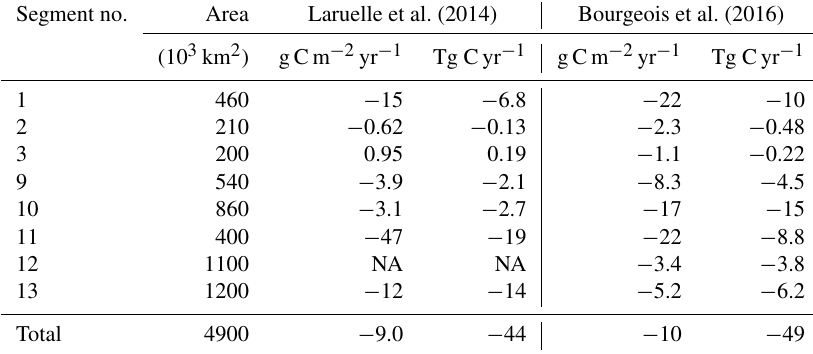
Table 1. Regional estimates of net air–sea CO 2 flux from a global data synthesis and a global biogeochemical model for the MARgins and CATchments Segmentation (MARCATS) regions. MARCATS segments are named as follows: (1) northeastern Pacific, (2) California Current, (3) eastern tropical Pacific, (9) Gulf of Mexico, (10) Florida upwelling, (11) Labrador Sea, (12) Hudson Bay, (13) Canadian Arctic Archipelago. Positive numbers indicate a flux to the atmosphere; 1Tg = 10 12 g. Segment no. Area Laruelle et al. (2014) (10 3 km 2 ) gCm − 2 yr − 1